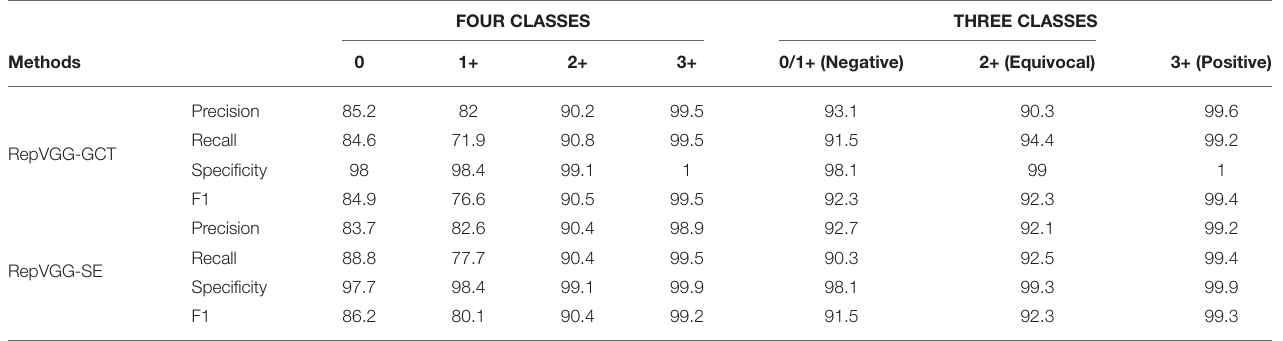
TABLE 5 | Classification performance of our RepVGG-GCT model and RepVGG-SE model in four classes and three classes. FOUR CLASSES